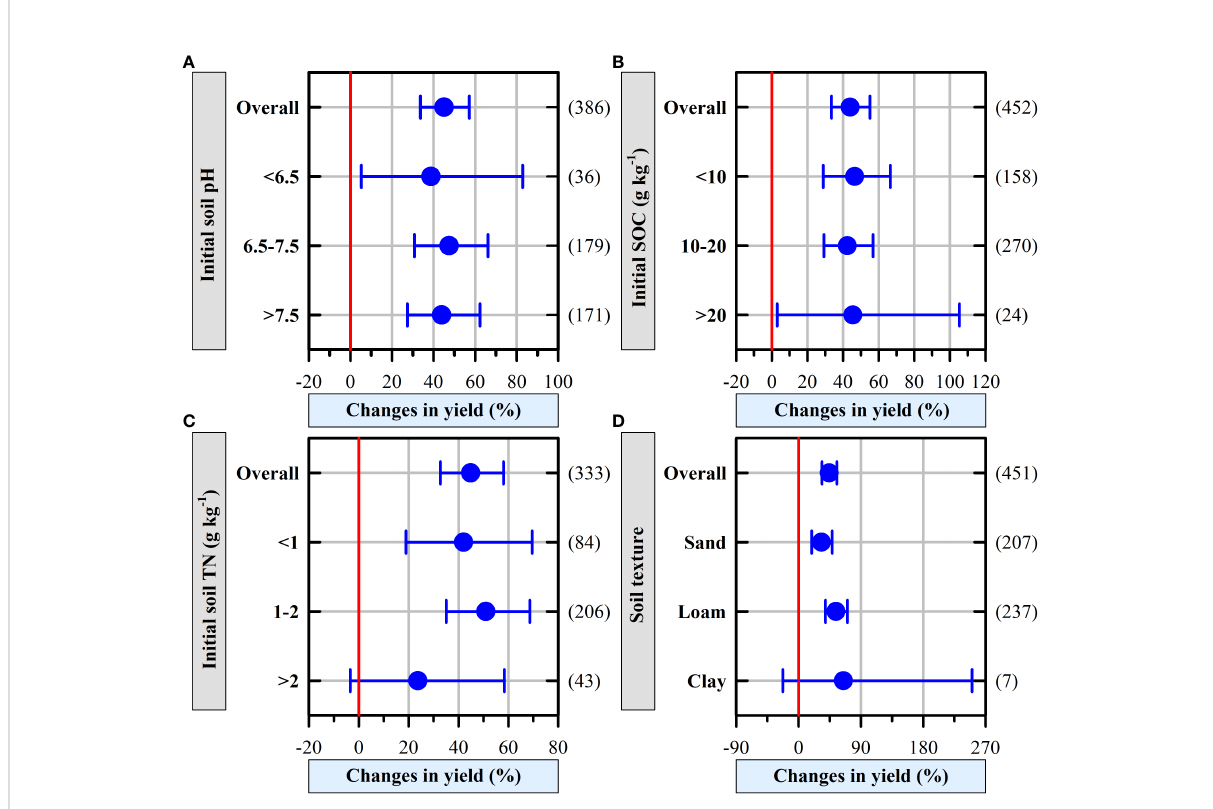
FIGURE 4 The effects of soil properties (A) initial soil pH, (B) initial SOC, (C) initial soil TN, and (D) soil texture on greenhouse vegetable yield. The numbers of observations are shown right parentheses. The blue horizontal bars represent the 95% con fi dence intervals (CIs). If the CI does not overlap with 0 red line, which indicates a signi fi cant effect at P <